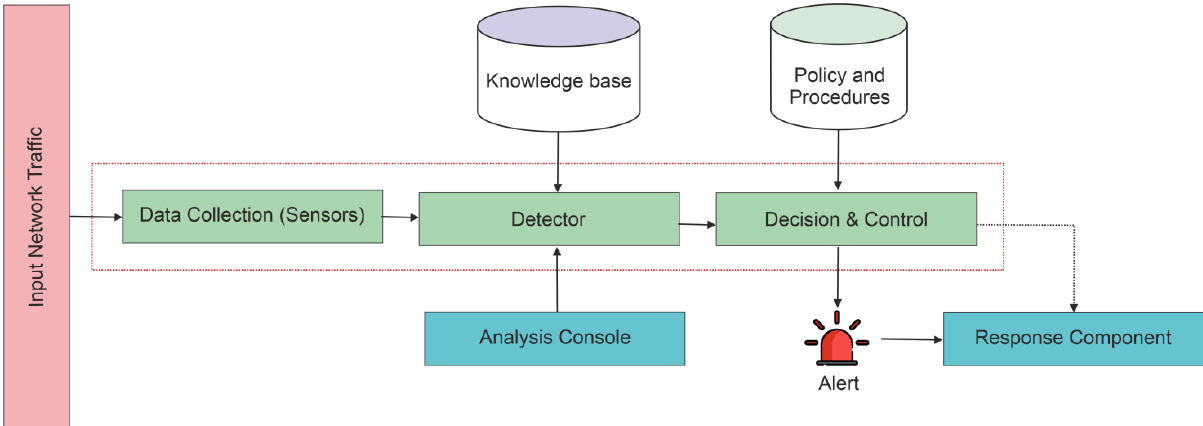
Figure 1. General architecture of intrusion-detection system (IDS).